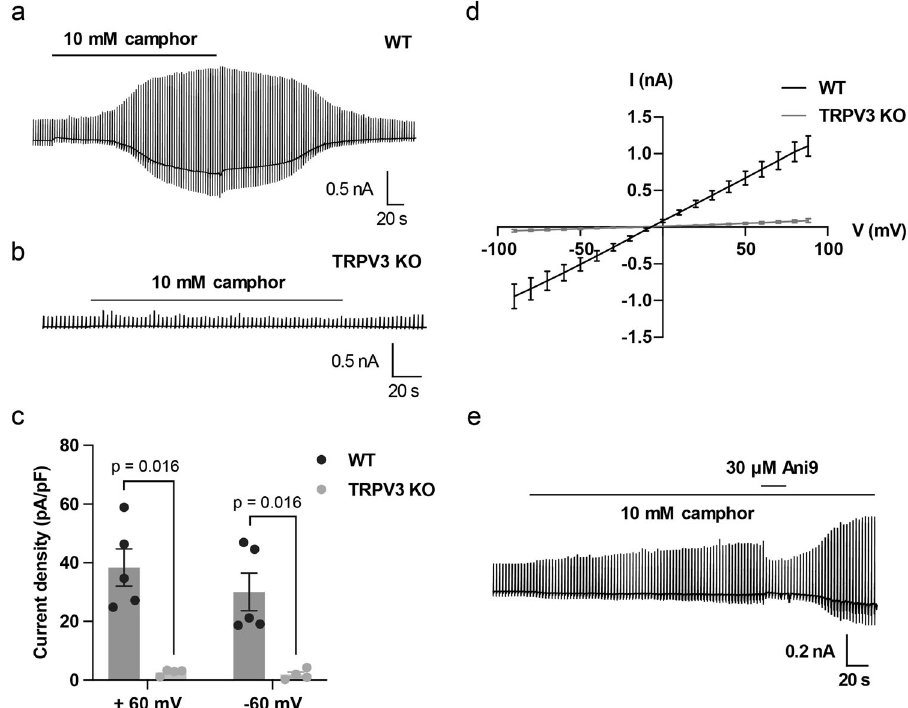
Fig. 4 TRPV3 and ANO1 interaction in mouse primary skin keratinocytes. a , b Representative traces of 10 mM camphor-induced currents in primary keratinocytes isolated from WT ( a ) and TRPV3 − / − ( b ) mice. All the recordings were performed with standard NMDG-Cl bath and pipette solutions (with 100 nM free calcium in the pipette). The holding potential was − 60 mV and ramp-pulses were applied from − 100 to + 100 mV for 300 ms duration every 3 s. c Comparison of current – voltage relationships. N equals 5 for WT (black) and 4 for TRPV3 − / − (gray) keratinocytes. Error bars indicate SEM. d Comparison of densities of the camphor-induced currents in WT (black) and TRPV3 − / − (gray) keratinocytes at + 60 and − 60 mV (means ± SEM). Statistical signi fi cance was determined with a Mann – Whitney test. e A representative trace of 10 mM camphor-induced currents with Ani9 inhibition in a WT keratinocyte. The holding potential was − 60 mV and ramp-pulses were applied from − 100 to + 100 mV for 300 ms duration every 3